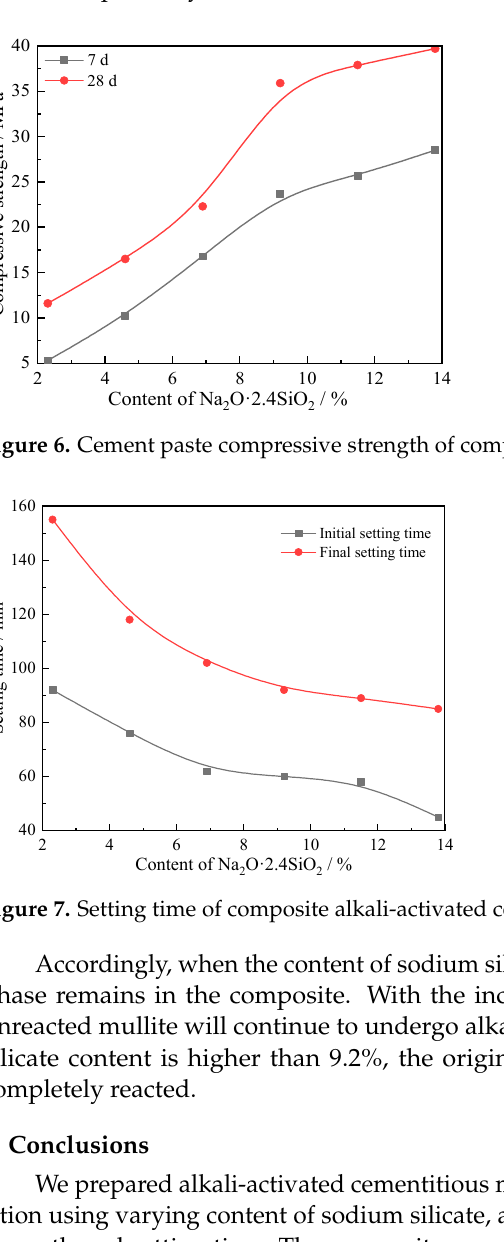
Figure 7. Setting time of composite alkali-activated cementitious materials.